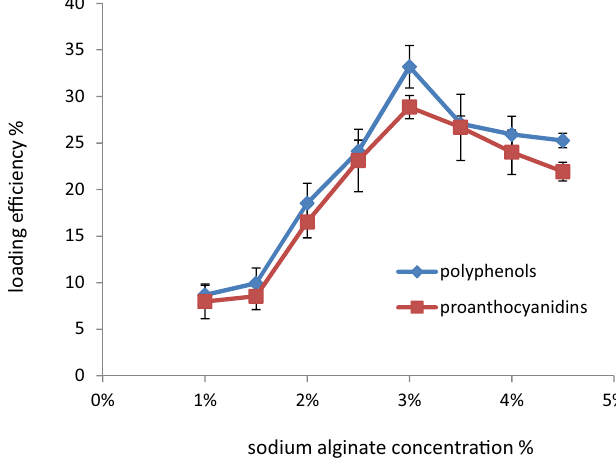
FIGURE 1 - Effect of sodium alginate concentration on total extractable polyphenols and proanthocyanidins loading efficiency. a Values are mean ± SD, (n =